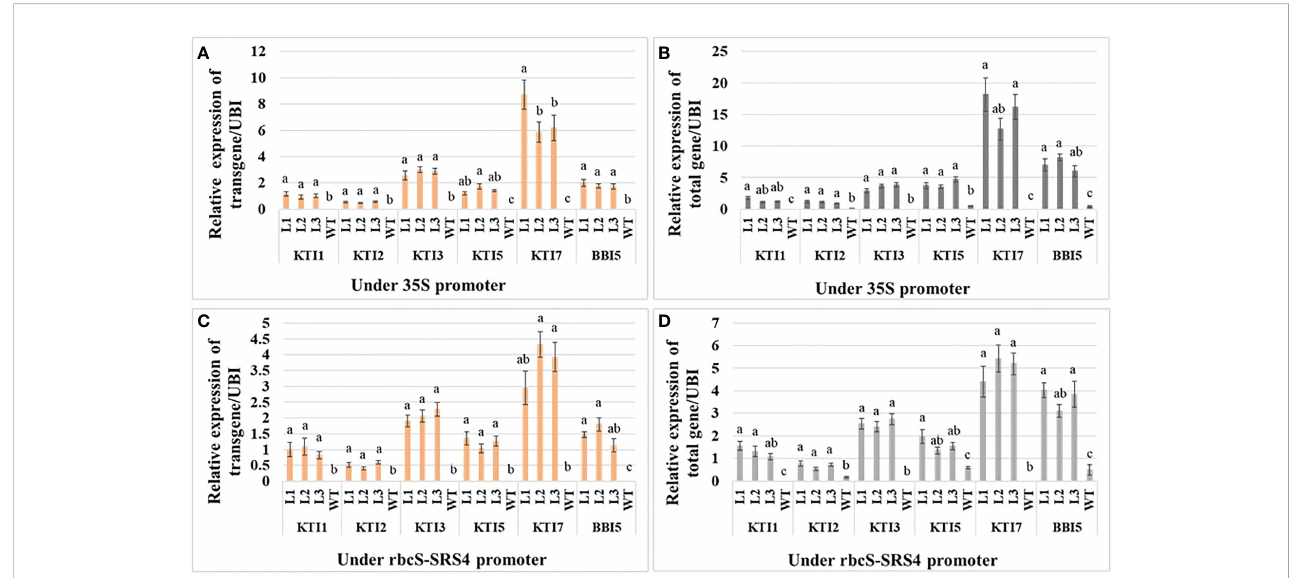
FIGURE 2 Expression analysis of the individual trypsin inhibitor gene construct in leaves of six-week-old T 3 transgenic and non-transgenic wild-type (WT) soybean plants. The relative expression of transgene (A) and total gene (B) corresponding to KTI1, KTI2, KTI3, KTI5, KTI7, and BBI5 under the control of 35S CaMV promoter. The relative expression of transgene (C) and total gene (D) corresponding to KTI1, KTI2, KTI3, KTI5, KTI7, and BBI5 under the control of rbcS- SRS4 promoter. The relative levels of transcripts were normalized to soybean ubiquitin gene ( GmUBI3 ). Bars represent mean values of six biological replicates (plants) per each independent line (L1, L2, L3) ± standard error. Each TI gene was statistically analyzed separately. Bars with different letters are signi fi cantly different at p < 0.05 as tested by one-way analysis of variance followed by a Fisher ’ s least signi fi cant